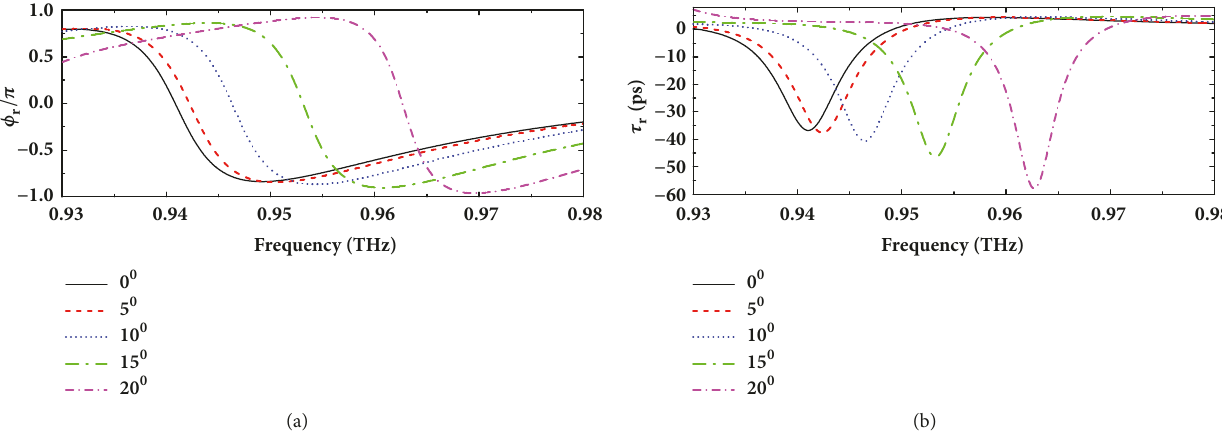
Figure 4: (a) Reflected phase 𝜙 𝑟 and (b) reflected group delay 𝜏 𝑟 as functions of frequency for different incident angel in the graphene-1D-PC structure. Other parameters are the same as